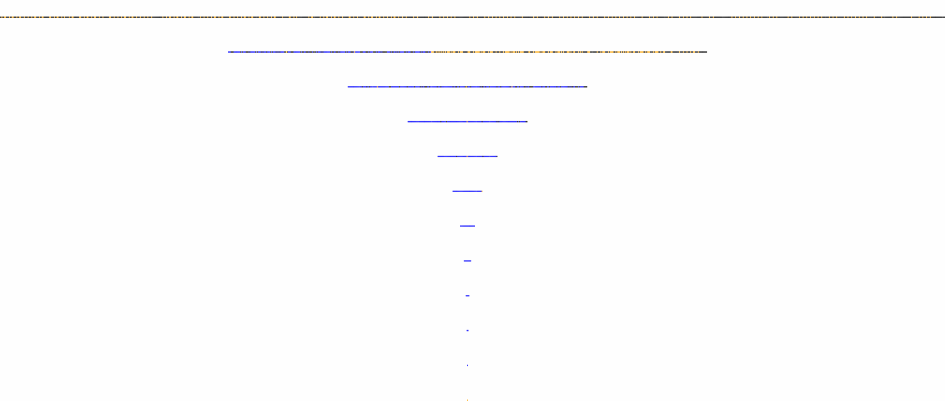
Figure 6. Case 12, instant state of the tree when the seventh row has just been completed.